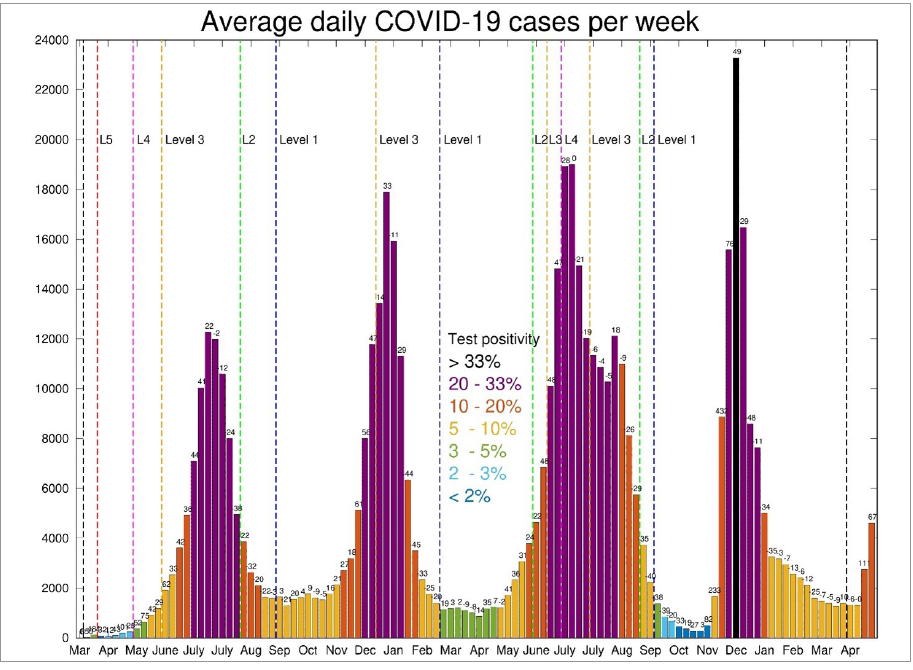
Figure 1: Average daily COVID-19 cases per week in South